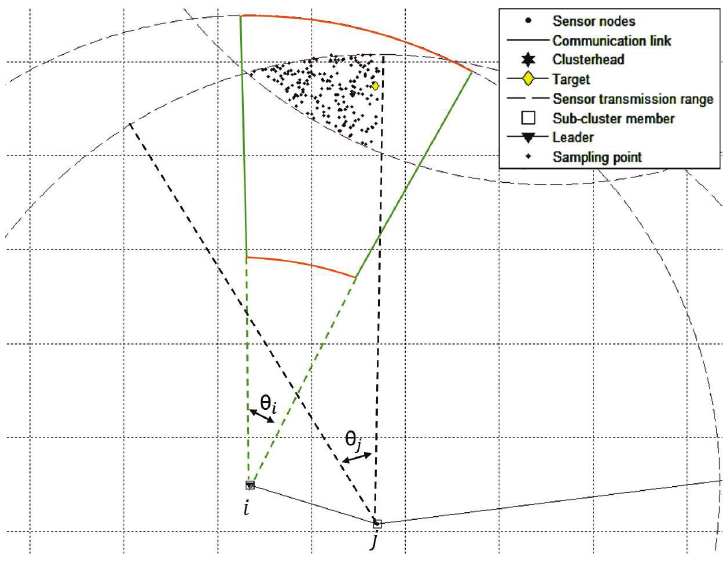
Figure 8. The intersection of sensor measurements and the area A, which leads to the distribution of the sampling points of